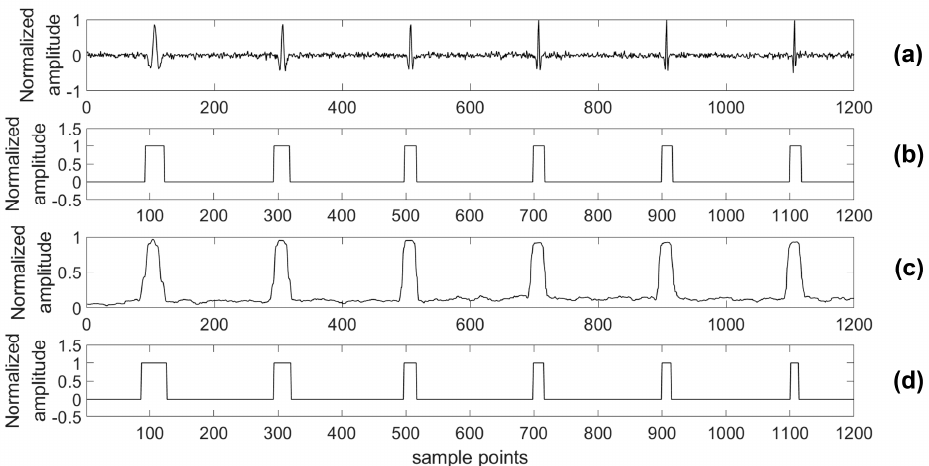
Figure 13. Channel B of test data (0 dB) and its results. ( a ) Test data (0 dB); ( b ) Detection results of the proposed algorithm; ( c ) Detection results of the STA/LTA algorithm; ( d ) The real label.